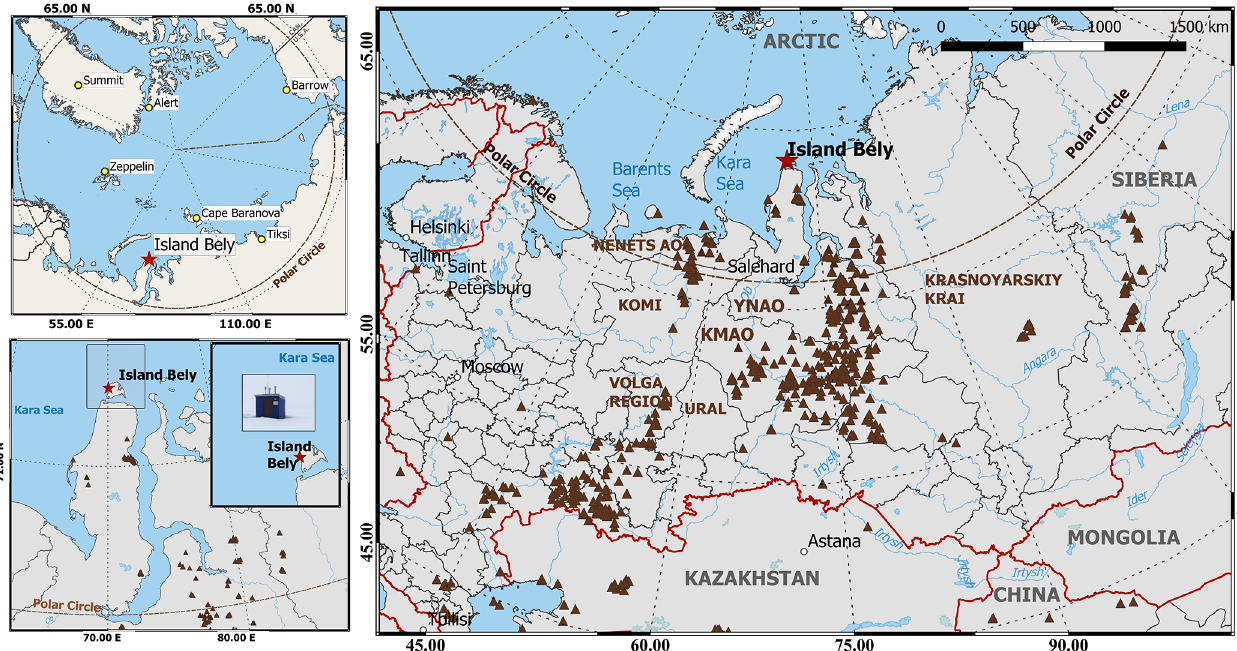
Figure 1. Top-left map shows the location of the newly established Island Bely aerosol station in contrast to other Arctic stations (Zeppelin, Alert, Barrow, Summit, Tiksi and Cape Baranova). Bottom-left map shows a zoomed-in version of the location of Bely Island in the Kara Sea, where the new station was developed (73 ◦ 20 (cid:48) 7.57 (cid:48)(cid:48) N, 70 ◦ 4 (cid:48) 49.05 (cid:48)(cid:48) E). The map on the right shows the Island Bely aerosol station in combination with the European part of Russia and western Siberia and the Yamalo-Nenets Autonomic Okrug (YNAO). Flares of oil and gas fields are shown for the year 2019 in brown triangles (adopted from https://skytruth.org/, last access: 1 April